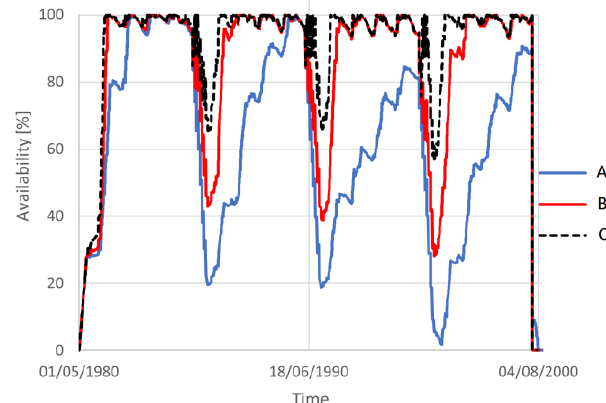
Fig. 23. Time series of availability over the life of the farm with c/d time=1 hr, assembly team=3. Scenario A: onshore teams=1, vessels=1. Scenario B: onshore teams=2, vessels=2. Scenario C: onshore teams=8, vessels=4.